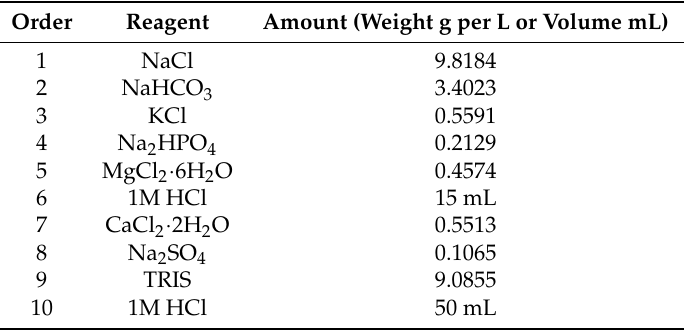
Table 3. Chemical composition of 1.5 ×